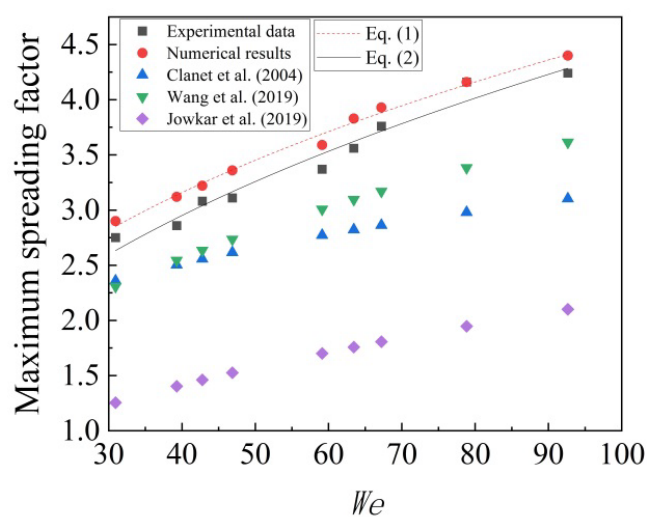
Figure 10. Effect of Weber number on the droplet maximum spreading factor. (Solid line represents the prediction of β max = 0.532 We 0.426 in experimental study, and dot line represents the prediction of β max = 0.724 We 0.396 in numerical simulation. The predictions of Clanet et al. [8], Wang et al. [39], and Jowkar [40] are used for